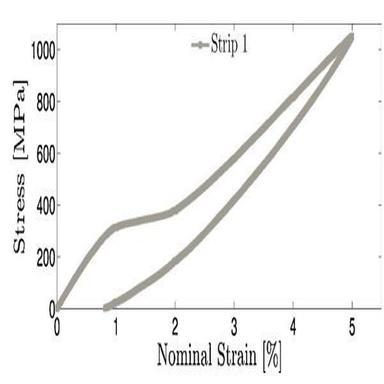
Stress-strain curve of tensile test performed during the digital image correlation procedure.